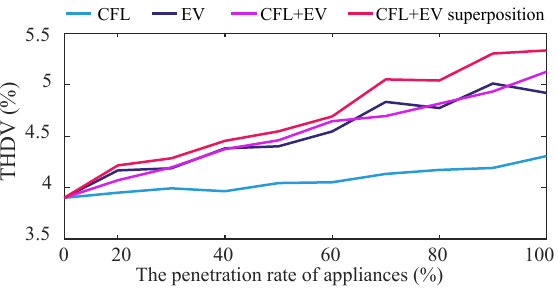
Figure 18. The 95 percentile value of THDV at the secondary side of the MV/LV transformer with the penetration level from